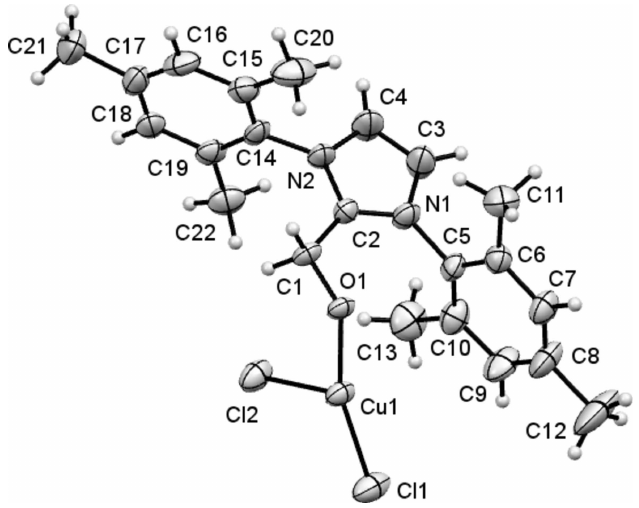
Figure 1 View of the contents of the asymmetric unit of (I). Non-H atoms are drawn as 50% probability ellipsoids and H atoms as small spheres of arbitrary size.